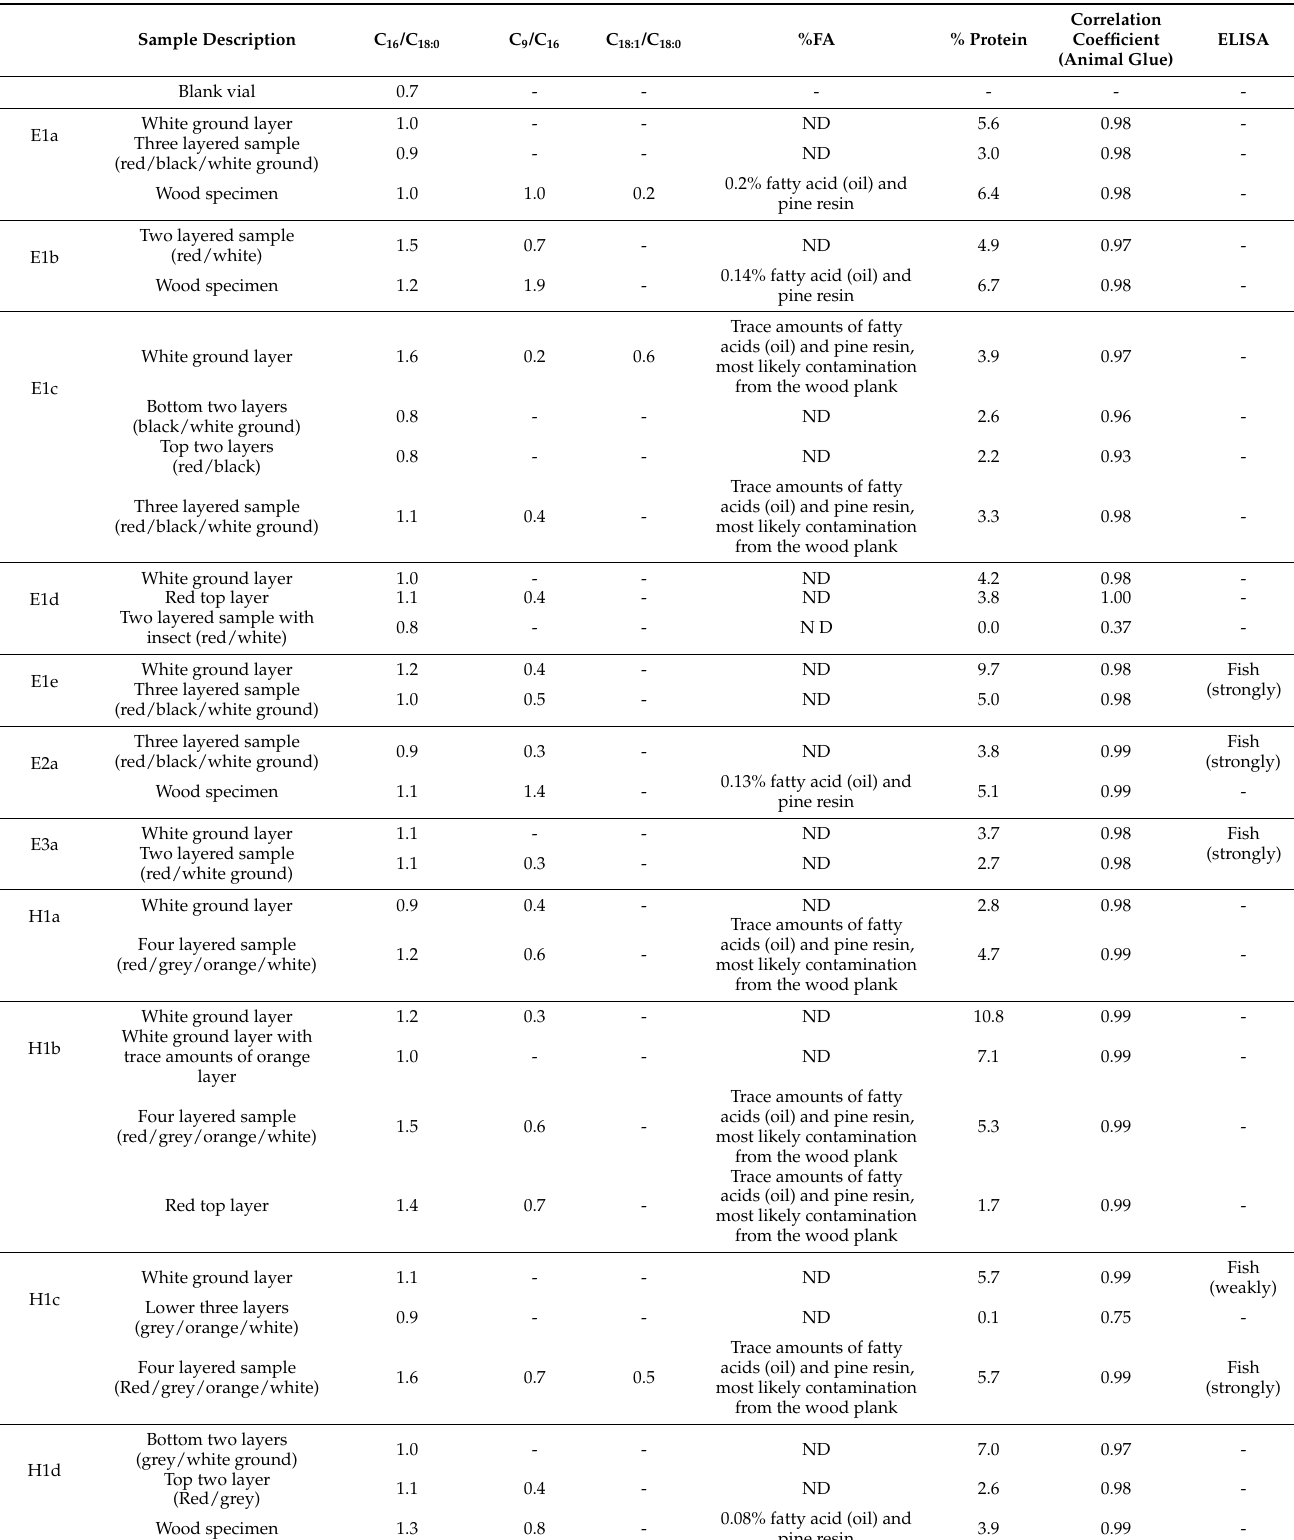
Table 4. Summary of results from Enzyme-Linked Immunosorbent Assay (ELISA) and gas chromatography-mass spectrome- try (GC-MS) analysis of historic paint samples and wooden specimen. Amino acid ratios (C 16 /C 18:0 , C 9 /C 16 , and C 18:1 /C 18:0 ) and percentage of fatty acid (%FA) of samples analyzed, where ND means not detected or below the detection limit. Corre- lation coefficient to animal glue and per cent protein (% protein) based on the weight of the specimen. ELISA is reported as strongly positive if optical density (OD) > 0.45 and weakly positive if OD < 0.3. See Supplementary Material for additional GC-MS data. Sample names correspond to those displayed in Figure 3 and listed in Table 2.